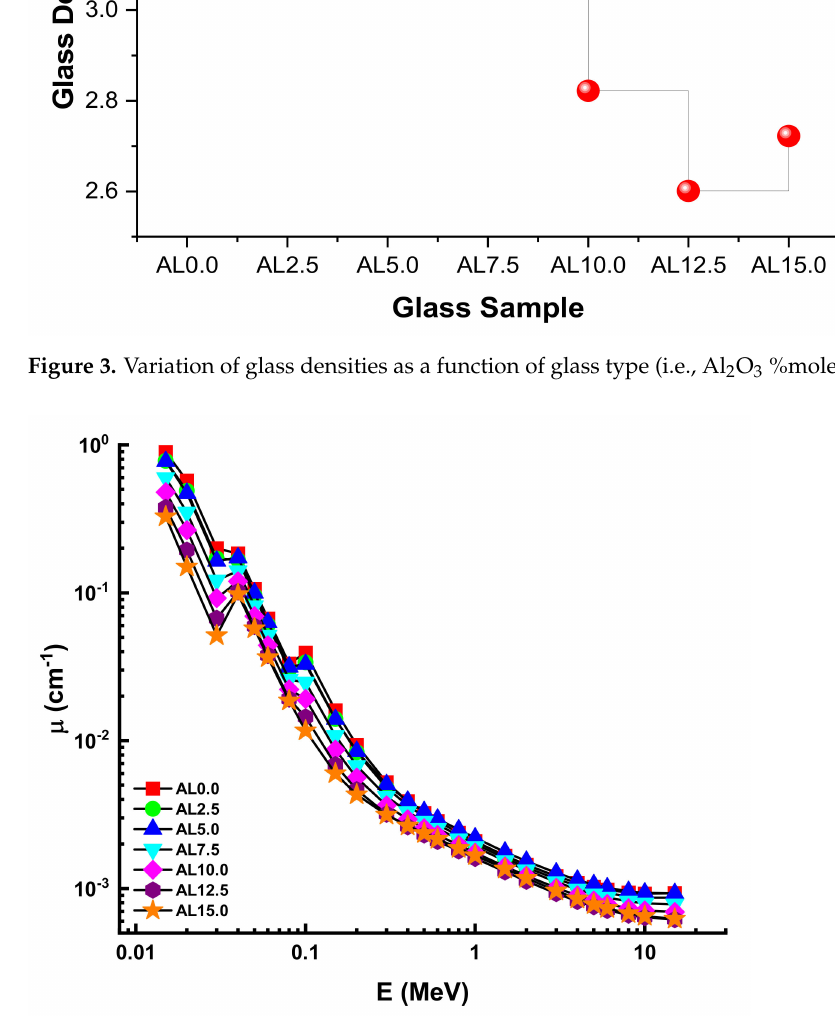
Figure 4. Variation of linear attenuation coefficient ( µ ) against photon energy for all